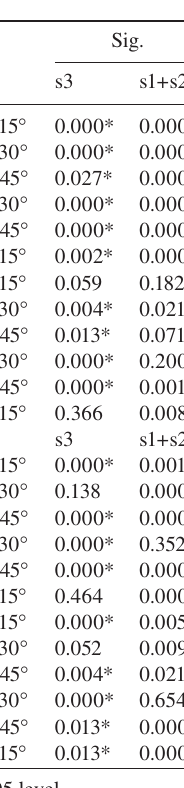
Table 6 ANOVA test results of Zweigle hairiness values.